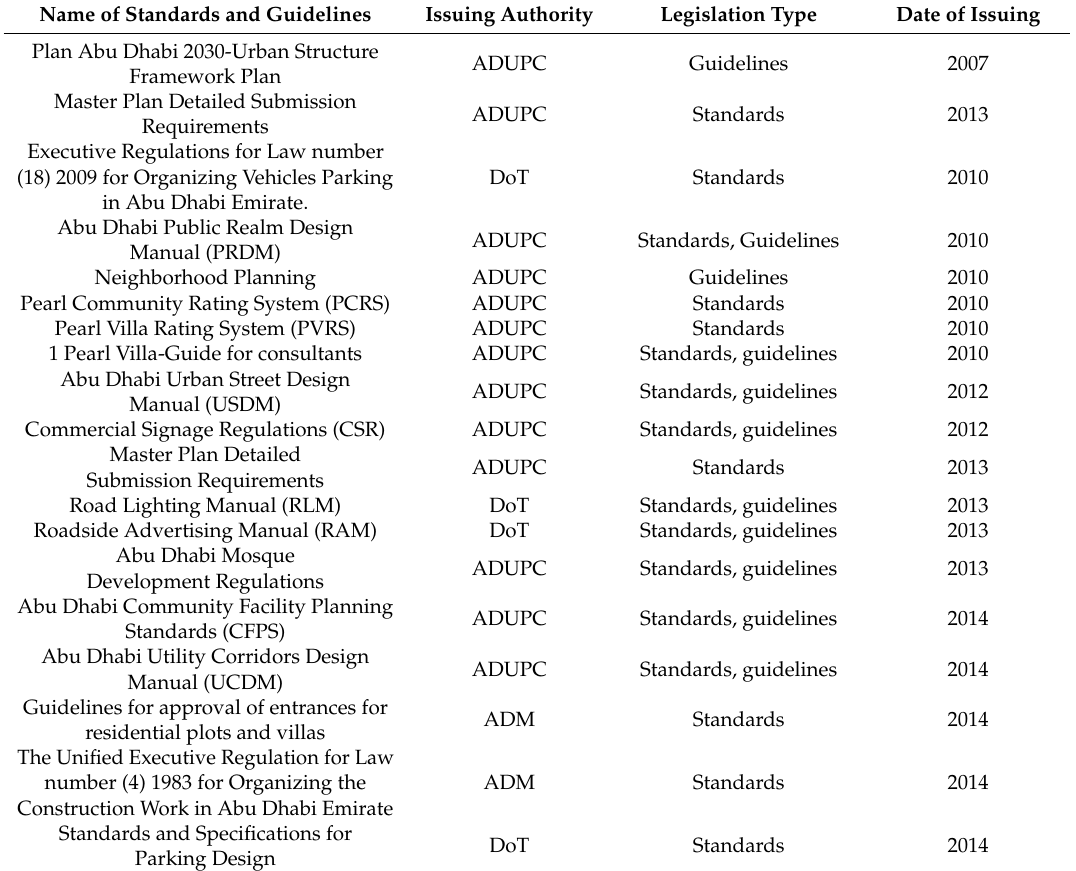
Table 1. Local urban form-related regulations and guidelines for new urban neighborhood in Abu Dhabi. ADUPC: Abu Dhabi Urban Planning Council; DoT: Department of Transportation; ADM: Abu Dhabi